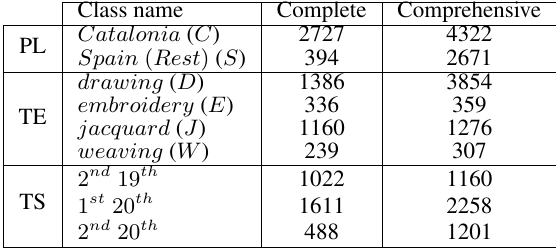
Table 1. Overview of the class distributions for all properties. TS: production timespan . PL: production place . TE: technique